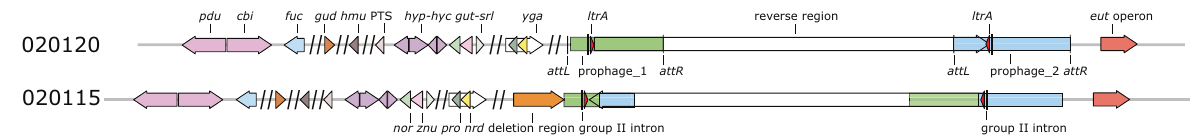
Fig. 7 The reversion of a region between the pdu - cbi module and the eut operon. Compared to that of C2_020115, a large region between the module of pdu (for utilizing 1,2-propanediol) and cbi (for cobalamin biosynthesis) of C1_020120 was reversed. This reversed region is fl anked by two identical 226-bp group II introns and their reverse transcriptase (RT)-encoding genes ltrA . In strain C1_020120, the two group II introns and ltrA genes belong to two different prophages, 61.3-kb prophage_1 (in light green) and 53.9-kb prophage_2 (in cyan), respectively. The two prophages are intact and have the attachment sites, attL and attR , at both sides. Homologous recombination between the two group II introns could reverse the intervening region including parts of the two prophages. The 10.5-kb region absent from clone 1 (Fig. S2) is also located between the pdu - cbi module and the eut operon and is indicated as ‘ deletion region ’ here. Other genes shown are fuc (encoding metabolism for L-fucose), gud (encoding glucarate dehydratase), hmu (encoding an ABC transporter complex involved in hemin import), PTS (encoding aphosphoenolpyruvate-dependent sugar phosphotransferase system), hyp-hyc (involving in hydrogenase biosynthesis), gut-srl (involving in metabolism of the hexitol D-glucitol), yga (encoding inner membrane and ribosome binding proteins with putative rhodanese activity), nor (for the expression of anaerobic nitric oxide [NO] reductase), znu (involving in the high-af fi nity zinc uptake transport), pro (involving in glycine betaine and proline betaine uptake), and nrd (encoding a ribonucleotide reductase system). This fi gure is not